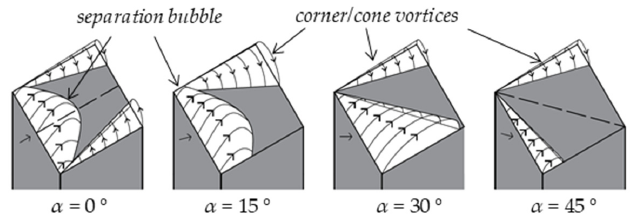
Figure 6. Expected flow patterns at the flow region for the different angles of attack. The approximate topology of cone vortices and separation bubbles is indicated along with the direction of the wind speed, as per previous numerical results [30,32,35].